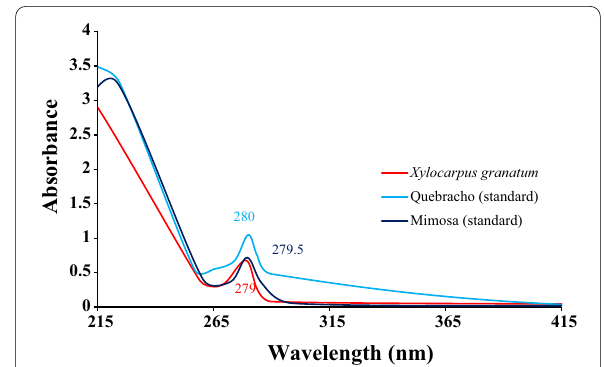
Fig. 3 UV Spectra of Xylocarpus granatum extract, mimosa, and quebracho tannin